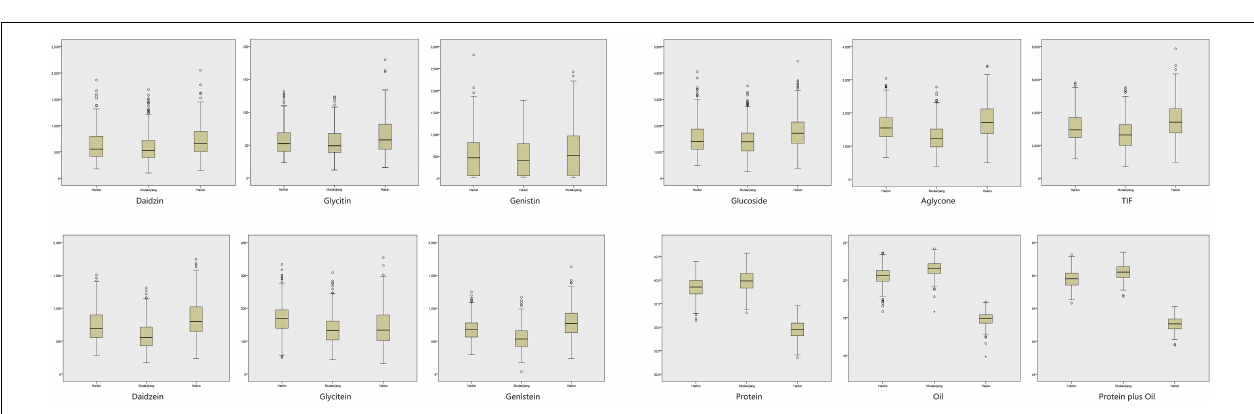
FIGURE 3 | The dynamic variation of reported genes expression in soybean seed during 10 DFA to 42 DAF (on the abscissa, the number 1 refers to 10 DAF, the number 2 refers to 14 DAF, the number 3 refers to 21 DAF, the number 4 refers to 25 DAF, the number 5 refers to 28 DAF, the number 6 refers to 35 DAF, and the number 7 refers to 42 DAF).